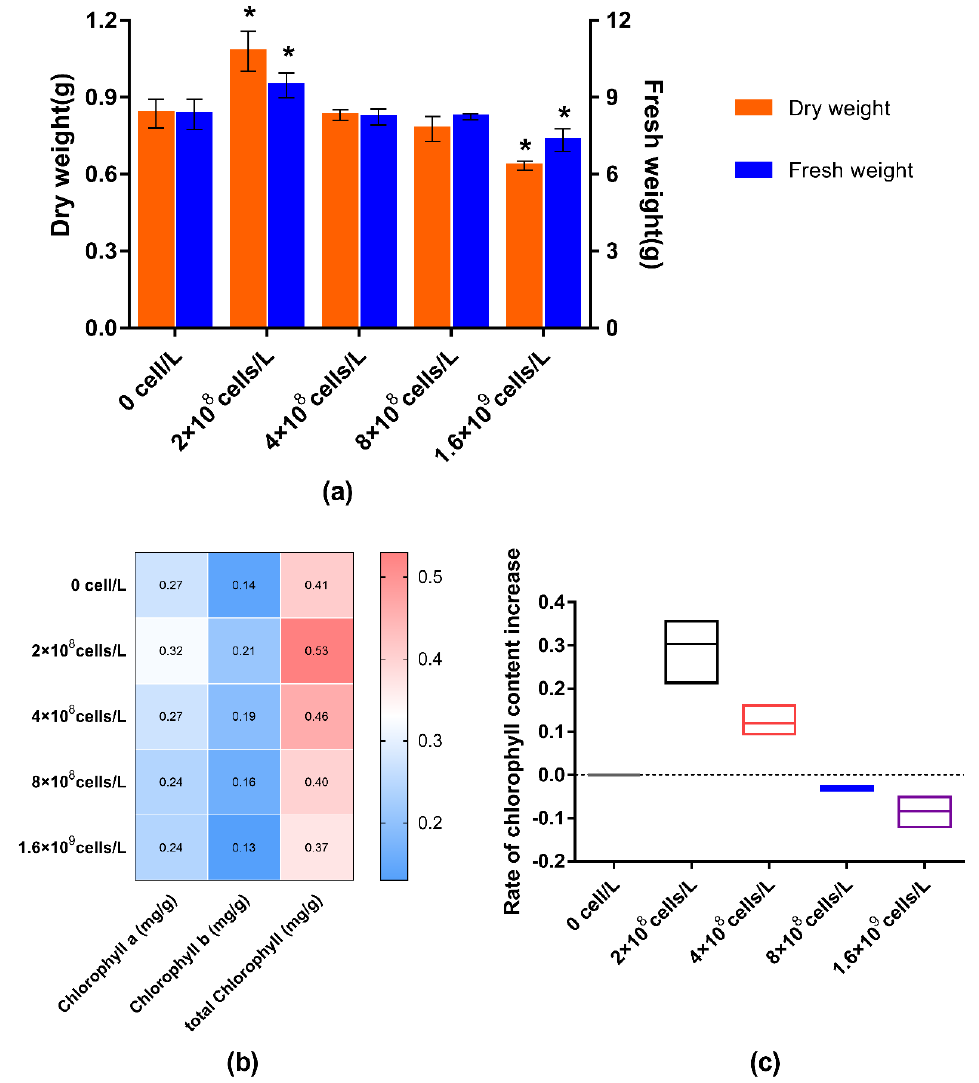
Figure 2. L. punctata growth states after co-culturing with M. aeruginosa . ( a ) Fresh biomass and dry biomass. ( b ) Chlorophyll content. ( c ) Rate of chlorophyll content increase. Values are means ± SE from three biological replicates. Asterisks indicate statistical significance based on one-way ANOVA; * p < 0.05.